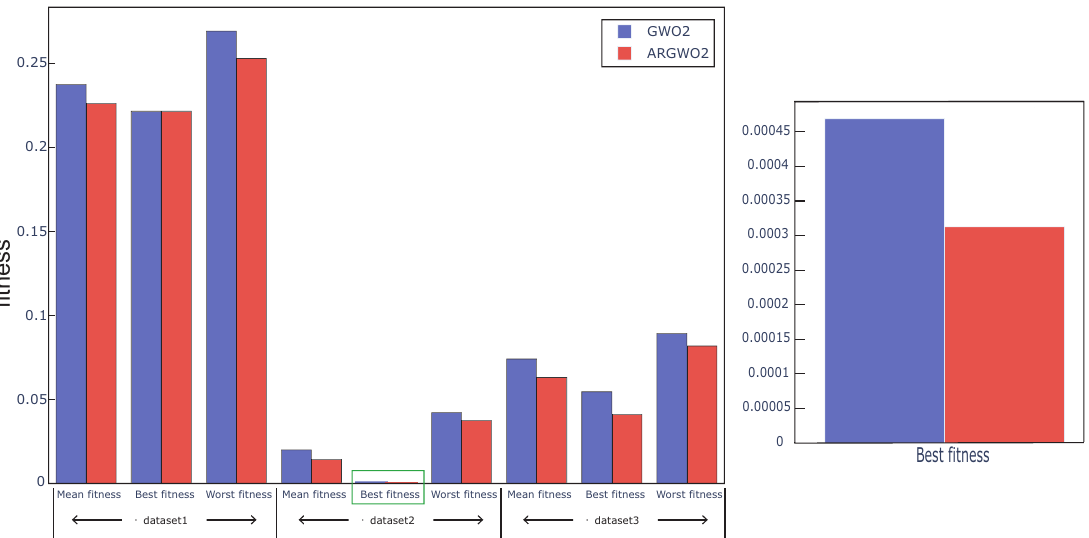
Figure 7. Mean, best, and worst fitness obtained from GWO2 and ARGWO2 over all datasets. The inset shows an expanded plot of the area in the green